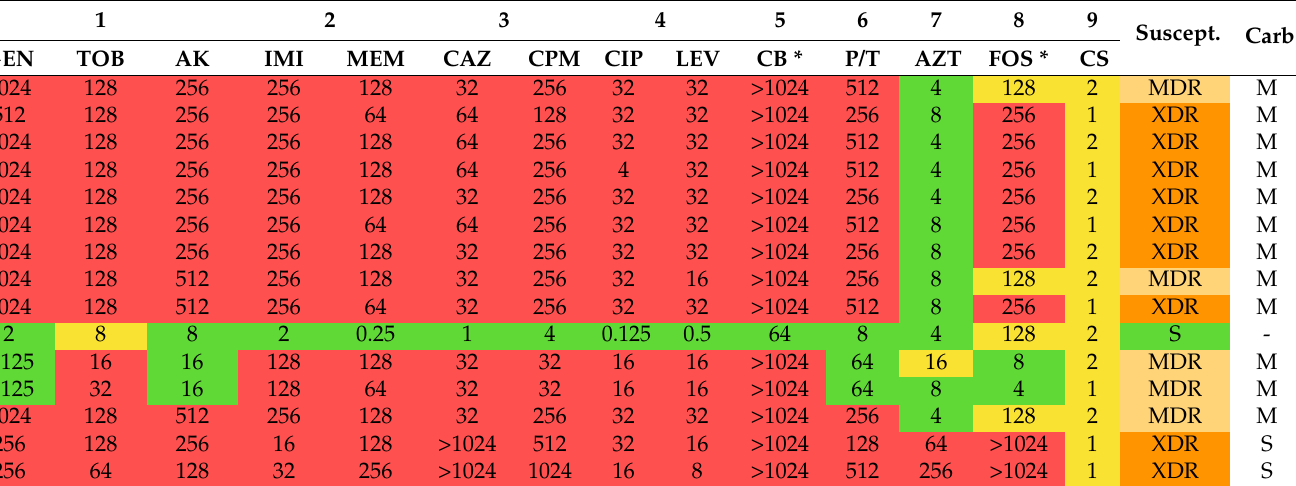
Table 1. Susceptibility profile of the P. aeruginosa strains and their